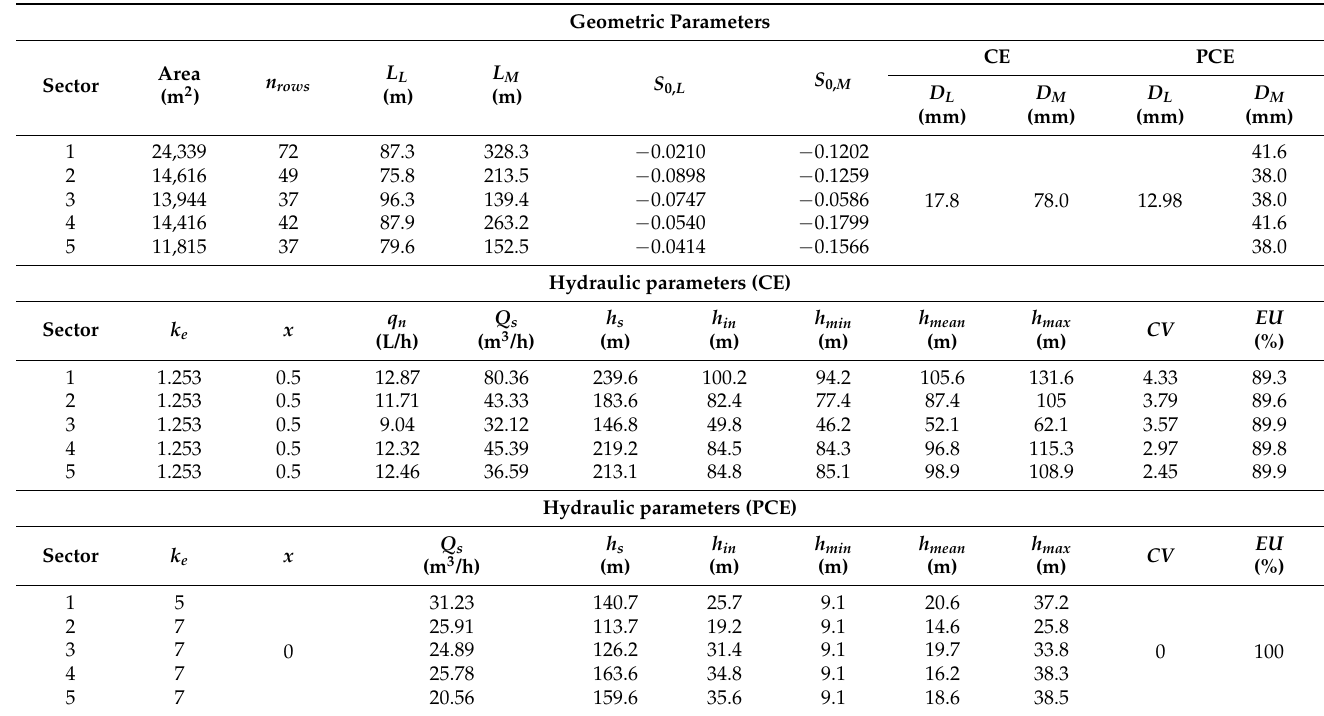
Table 5. Geometric and hydraulic design parameters for the actual “non-uniform” five sectors of the apple farm, designed by IRRIPRO, for common emitters (CE) and pressure compensating emitters (PCE). Geometric